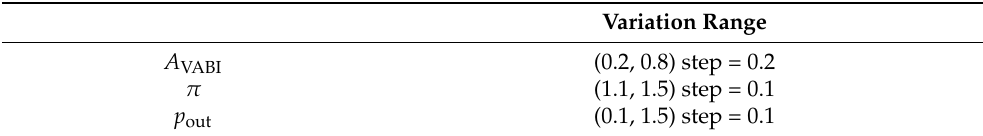
Table 2. Calibration database for the VABI model.